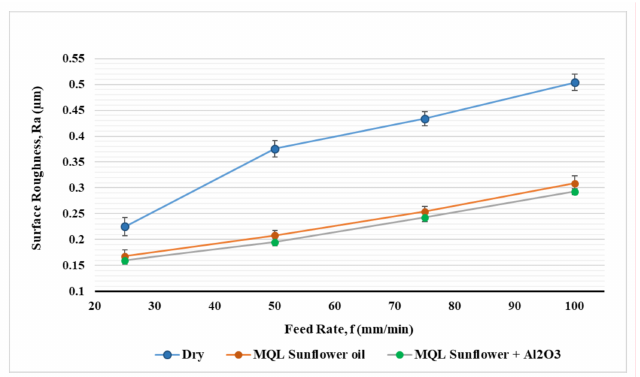
Figure 11. Effect of cooling strategies on surface roughness under different feed rates.